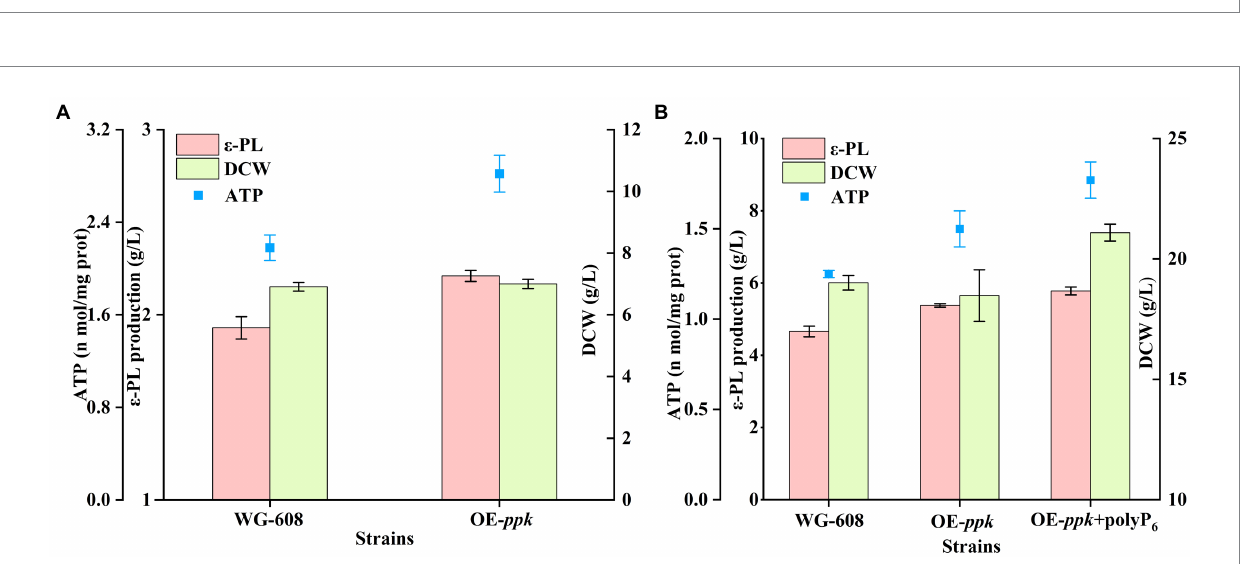
FIGURE 5 Enhancement of ε -PL production with overexpressing ppk gene and polyP 6 feeding. (A) Shake-flask fermentation of S. albulus WG-608 and OE- ppk . (B) Batch-fermentation of OE- ppk with polyPP 6 addition and S. albulus WG-608. DCW, dry cell weight, red box represents ε -PL production, green box represents DCW (dry cell weight), whereas blue dot represents ATP